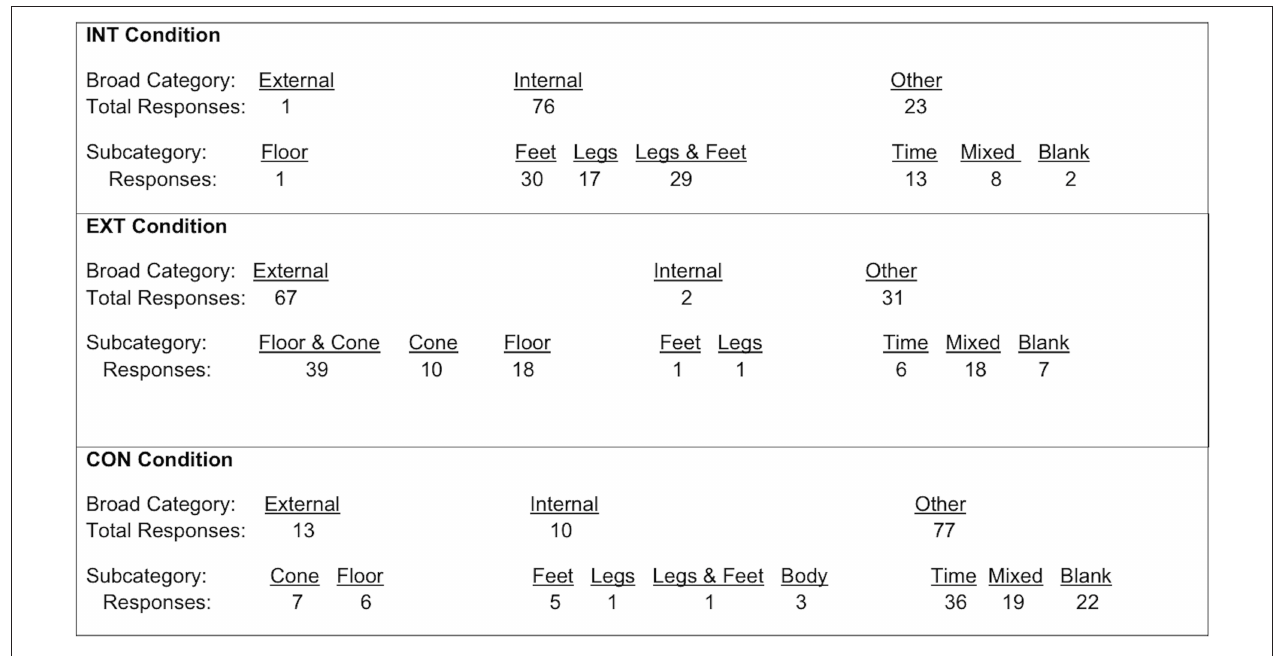
Figure 3 | in-depth breakdown of questionnaire response categories. Each number represents the total number of questionnaire responses in each of the broad and subcategories for each experimental condition. The total number of responses in each subcategory equals the number listed in its corresponding